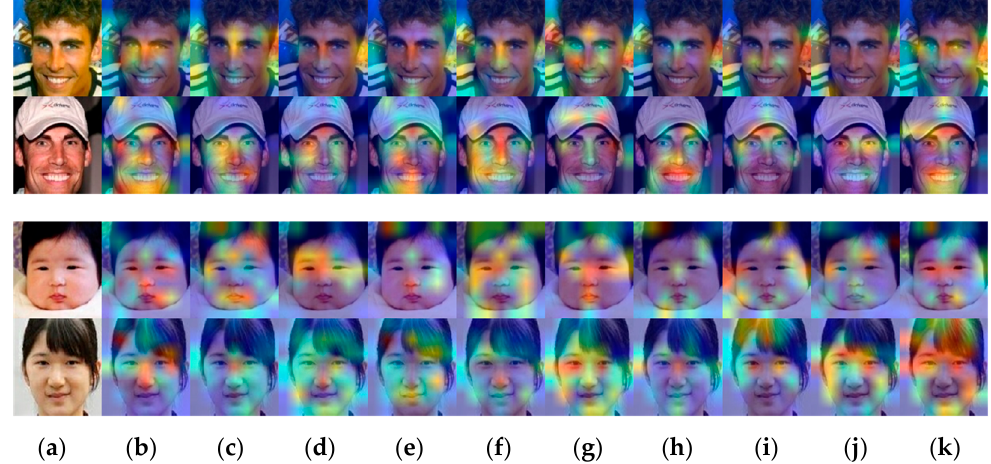
Figure 11. Two random face image pairs from CALFW [41] dataset. The original image pairs are shown in ( a ). Corresponding Grad-CAM visualization for the baseline pair is depicted in ( b ), and other a tt ention modules are depicted from ( c – j ), while the proposed a tt ention module of this work is illustrated in ( k ), all arranged column-wise from left to right. ( a ) Original face image pairs; ( b ) ConvFaceNeXt; ( c ) SE; ( d ) ECA; ( e ) CBAM; ( f ) ECBAM; ( g ) CA; ( h ) SCA; ( i ) TA; ( j ) DAA; ( k ) LCAM.